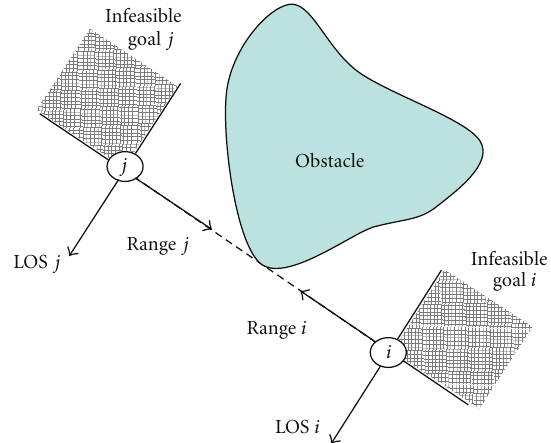
Figure 6: A generic pair of robots, with active line of sight and range constraints. Figure indicates possible directions of − ( ∂/∂q ) φ goal that could result in no feasible direction for simultaneously satisfying three